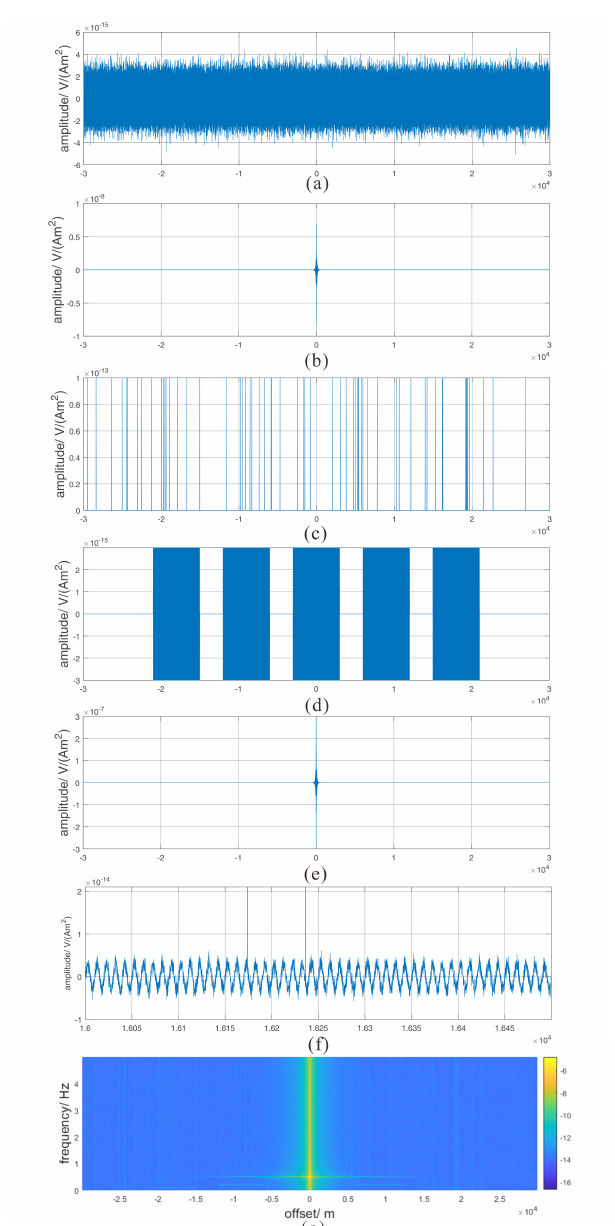
Figure 7. All the added noise and the contaminated signal. ( a ) illustrates the random noise, ( b ) shows the internal noise, ( c ) presents impulses to simulate dipole vibrations and ( d ) shows low frequency noise to simulate seawater motions. ( e ) is the overview of the contaminated signal, in which the clear signal comes from the above simulation, ( f ) is the partial enlarged view of the signal ( g ) presents the time-frequency characters of the contaminated